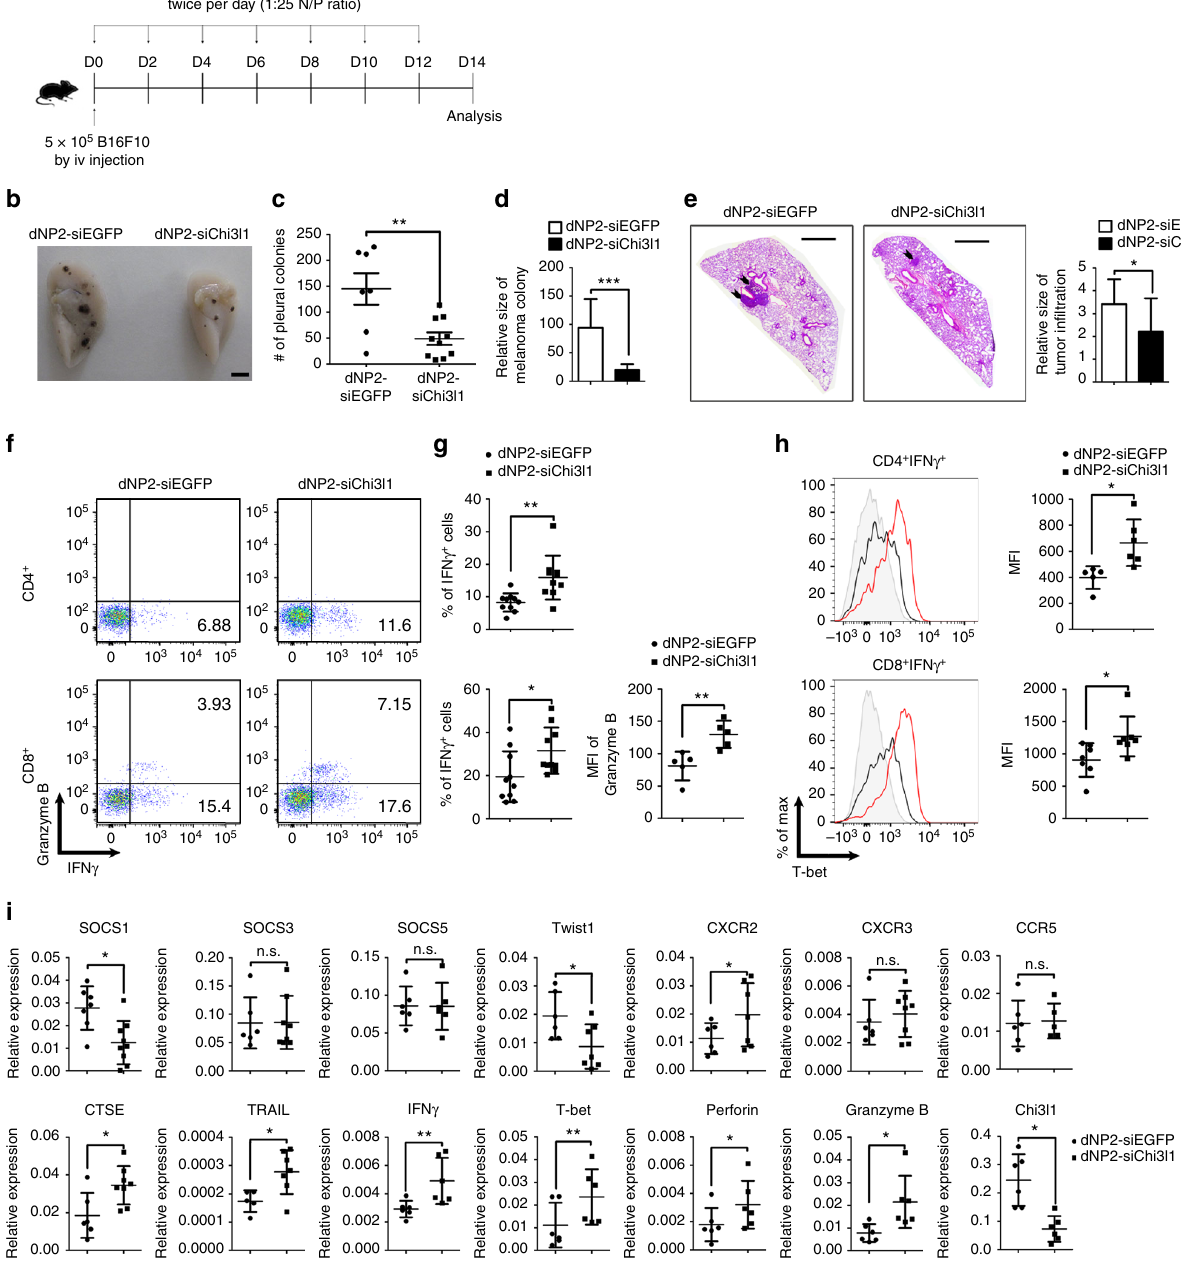
Fig. 9 In vivo administration of dNP2-siChi3l1 complex inhibits pulmonary metastasis with enhanced Th1 and CTL effector molecules. a Experimental scheme of dNP2-siRNA complex treatment in pulmonary melanoma metastasis model. b Representative lung image of dNP2-siEGFP and dNP2-siChi3l1- treated mice. Scale bar, 2 mm c Number of pleural colonies in each lung was counted. Data are mean ± SEM of three sets of independent experiments and each dot in graphs represent an individual mouse. d Relative total tumor area in the lung was measured by Image J software 1.48 v. e Histology of lung sections by H&E staining, and in fi ltrated tumor region was measured by Image J software 1.48 v. Scale bar, 200 m f , g IFN γ producing CD4 and CD8 T cells, and Granzyme B expression level in IFN γ + CD8 T cells in the lung was analyzed by intracellular staining. % of IFN γ + , and MFI of Granzyme B was represented as scattered graph. h Intracellular T-bet expression level in CD4 + IFN γ + and CD8 + IFN γ + population. MFI was represented as scattered graph. i mRNA expression of genes related to cytotoxicity and Th1 effector functions was analyzed by quantitative RT-PCR. Each gene expression level was normalized to β -actin. Data are mean ± SD of three sets of independent experiments and each dot in graphs represent an individual mouse. n.s., not signi fi cant; * p < 0.05, ** p < 0.01, *** p < 0.001 (two-tailed Student ’ s t